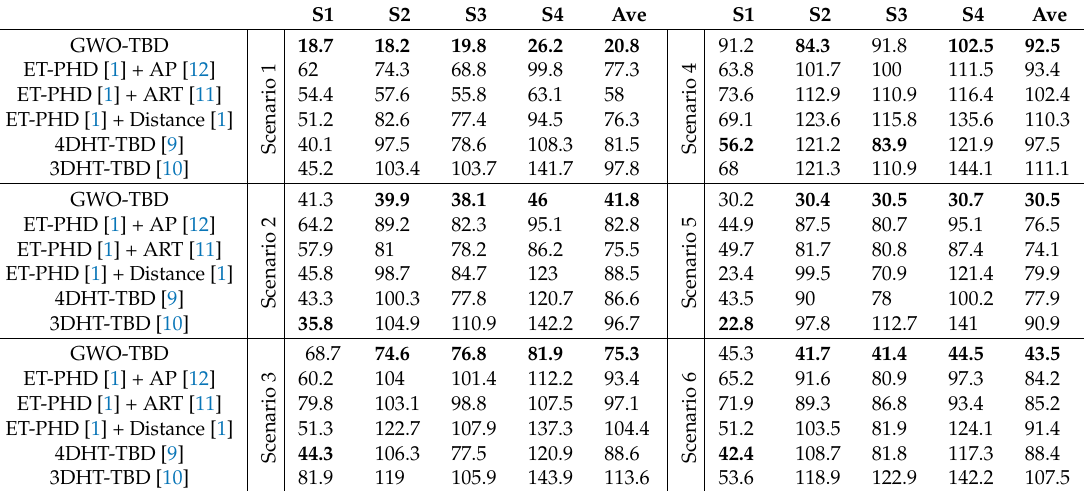
Table A2. OSPA distance of synthetic